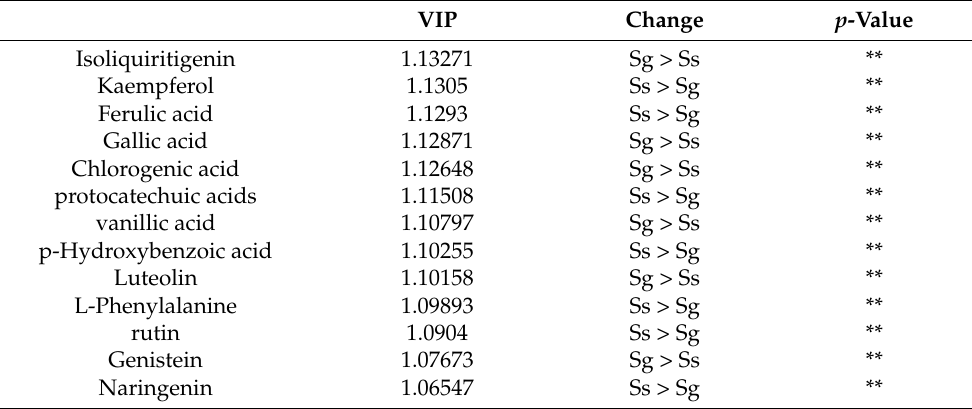
Table 3. Significantly different phenolic compounds between S. glauca and S. salsa . VIP Change p